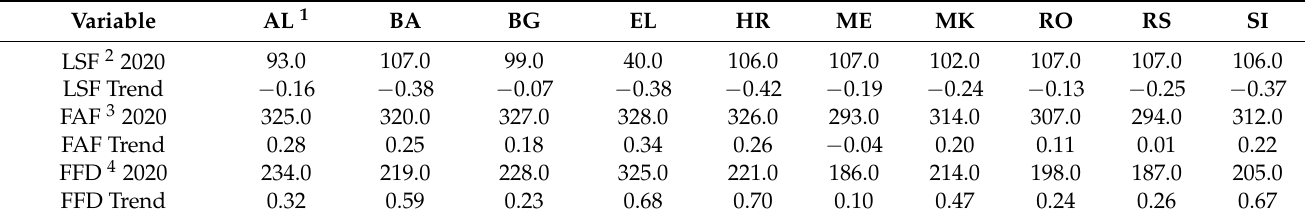
Table 4. The medians per variable and country for the frost parameters.